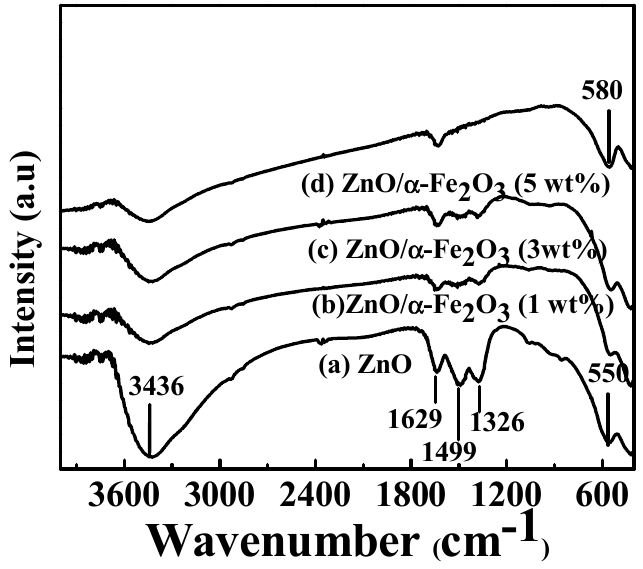
Figure 2. FT-IR spectra of ( a ) ZnO; ( b ) ZnO / α -Fe 2 O 3 (1 wt%); ( c ) ZnO / α -Fe 2 O 3 (3 wt%); and ( d ) ZnO / α -Fe 2 O 3 (5 wt%).